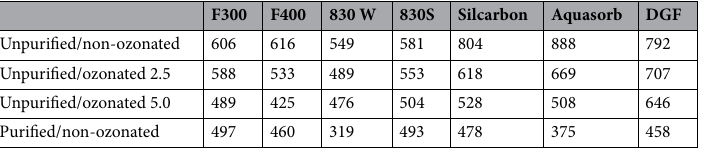
Table 3. Alkalinity (in µeq/g) of activated carbons: unpurified, non‑ozonated, unpurified ozonated (at pH 2.5 and 5.0) and purified